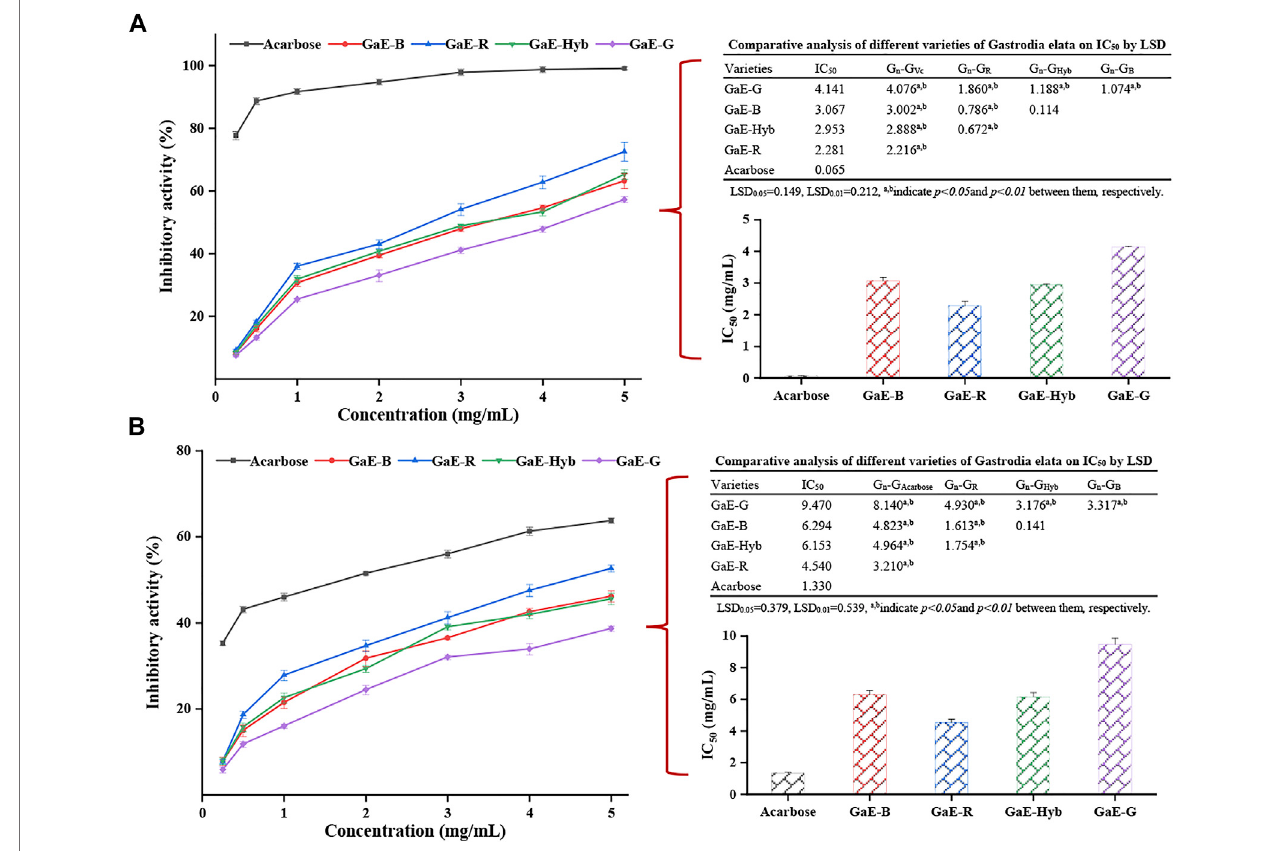
FIGURE 8 | Hypoglycemic activities of the different varieties of Gastrodia elata polysaccharides at different concentrations in vitro : (A) α -amylase inhibitory activity and IC 50 values and (B) α -glucosidase inhibitory activity and IC 50 values. Each value is expressed as means ± standard deviation (SD) of triplicate measurements.